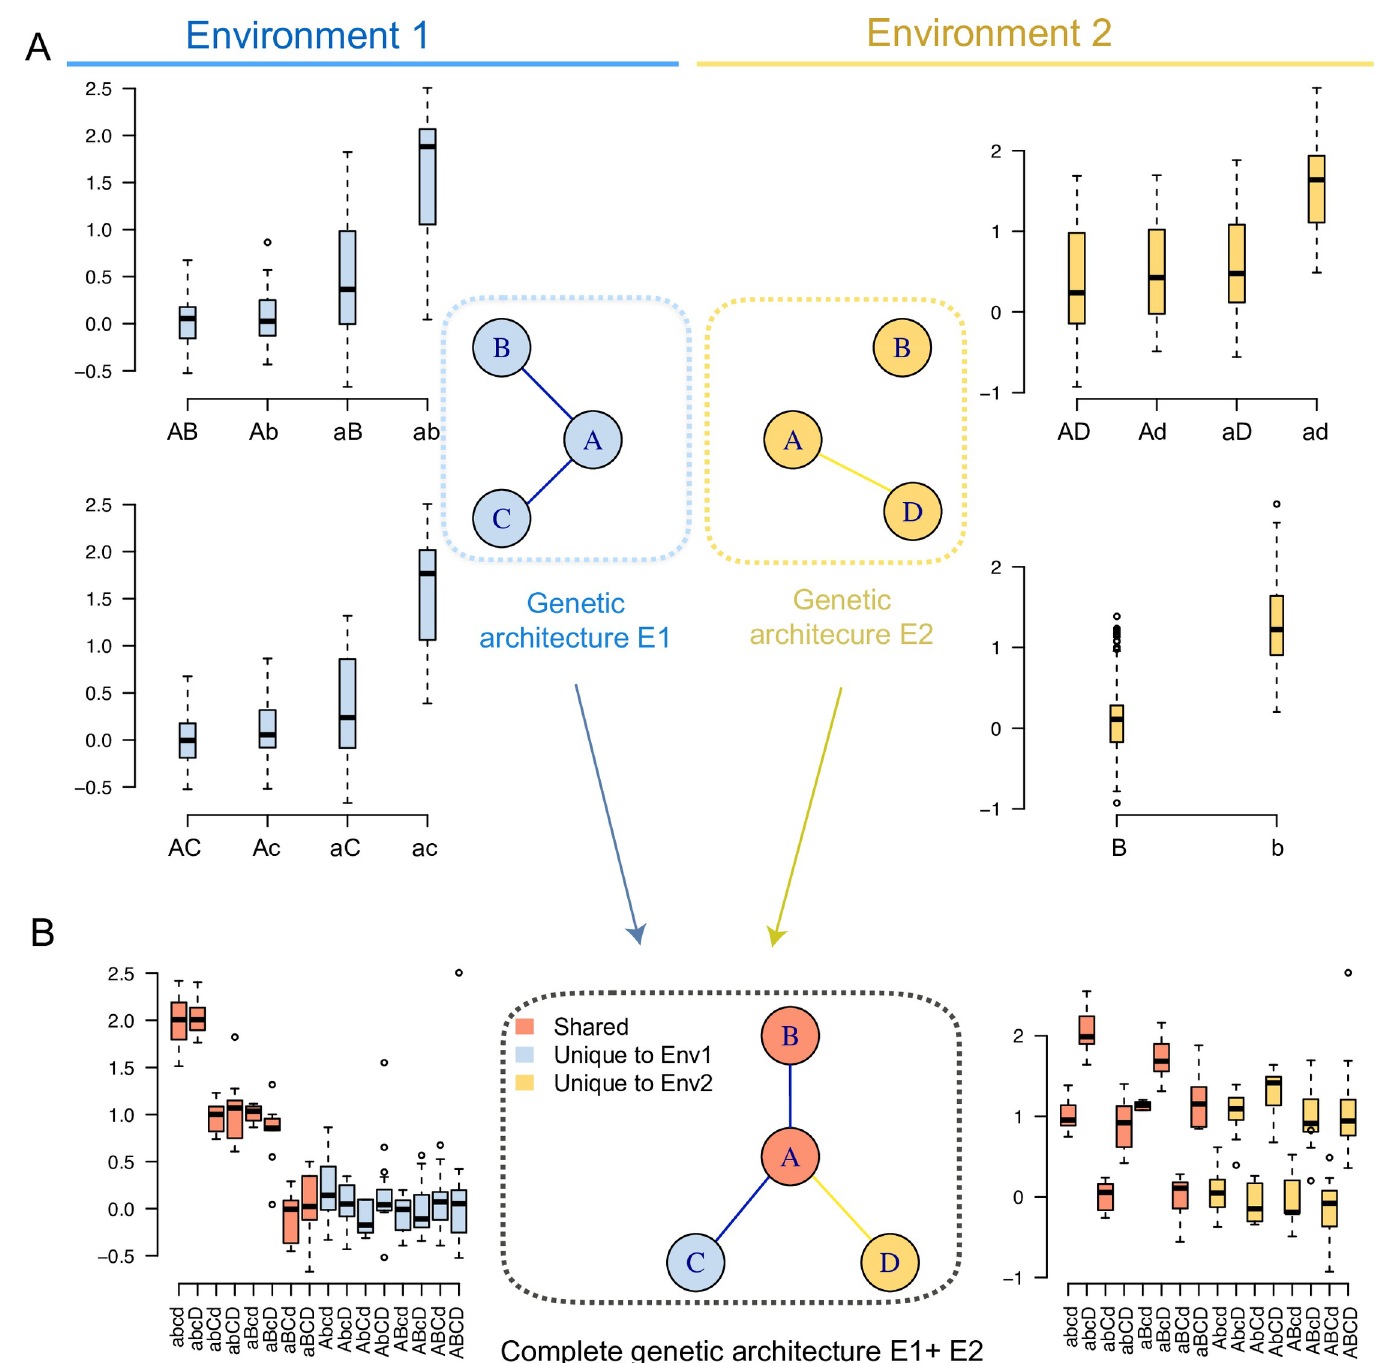
Fig 1. A schematic illustration of how an epistatic, across environment QTL network is defined and its phenotypic effects in response to environmental perturbations are evaluated. Epistatic networks are constructed based on results from association analyses modelling two-locus interactions. The circles represent QTL (A-D) involved in significant pairwise interactions contributing to growth ( A ; blue/yellow in environment 1/2, respectively). Interaction networks are first constructed for the environments separately by connecting significantly interacting loci ( A ; blue/yellow lines). The complete set of loci and pairwise interactions are next used to define a complete across environment growth interaction network ( B ). All the within-environment networks are therefore sub-networks. The multi-locus genotype-phenotype maps for the within-environment ( A ) and across environment ( B ) networks are illustrated using box-plots where the growth of the segregants relative to that in a standard environment (y-axis) are given for the evaluated single- or multi-locus genotypes (x-axis). Two networks are evaluated in (A) showing how loci contribute to growth in each of the two environments, resembling the results reported in earlier studies of this population [31]. In B) the additional analyses performed here to explore the dynamics in the genetic regulation of yeast growth in response to environmental perturbations are illustrated. Here, the complete across-environment interaction network